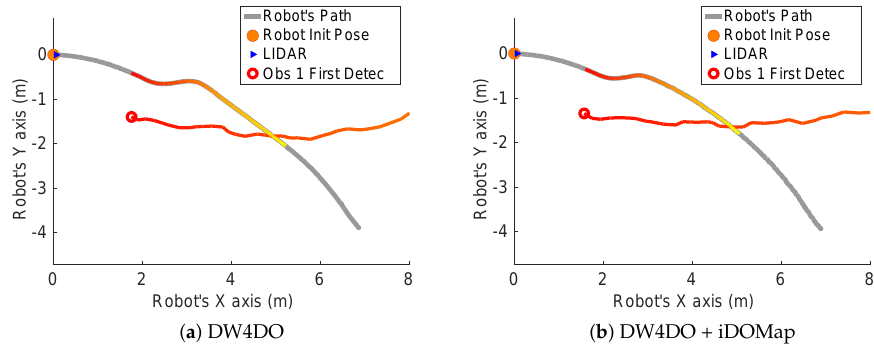
Figure 34. Scenario 3—Robot Paths and iDOMap Detections.